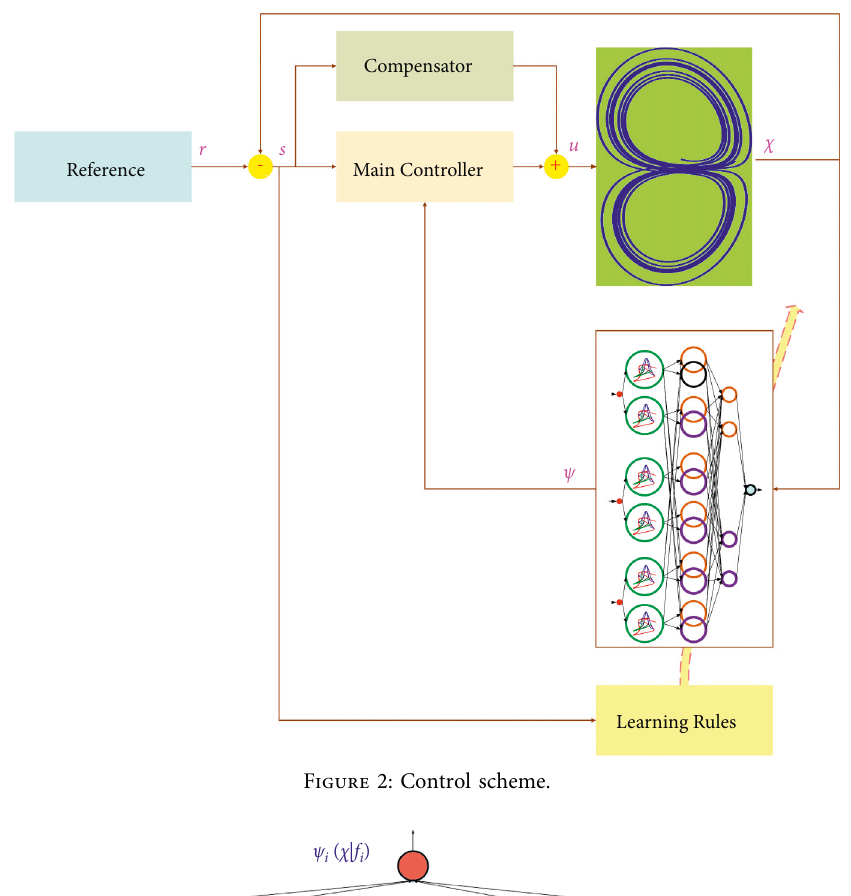
Figure 2: Control scheme.